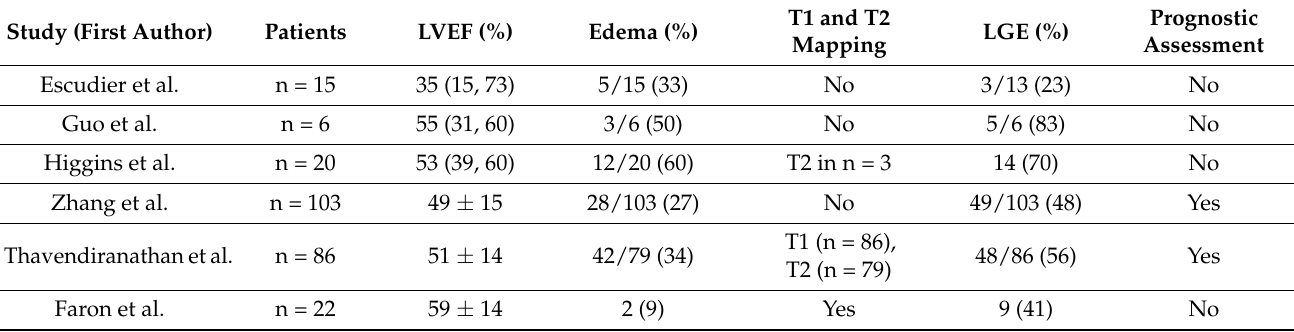
Table 1. CMR characteristics of patients enrolled in the selected